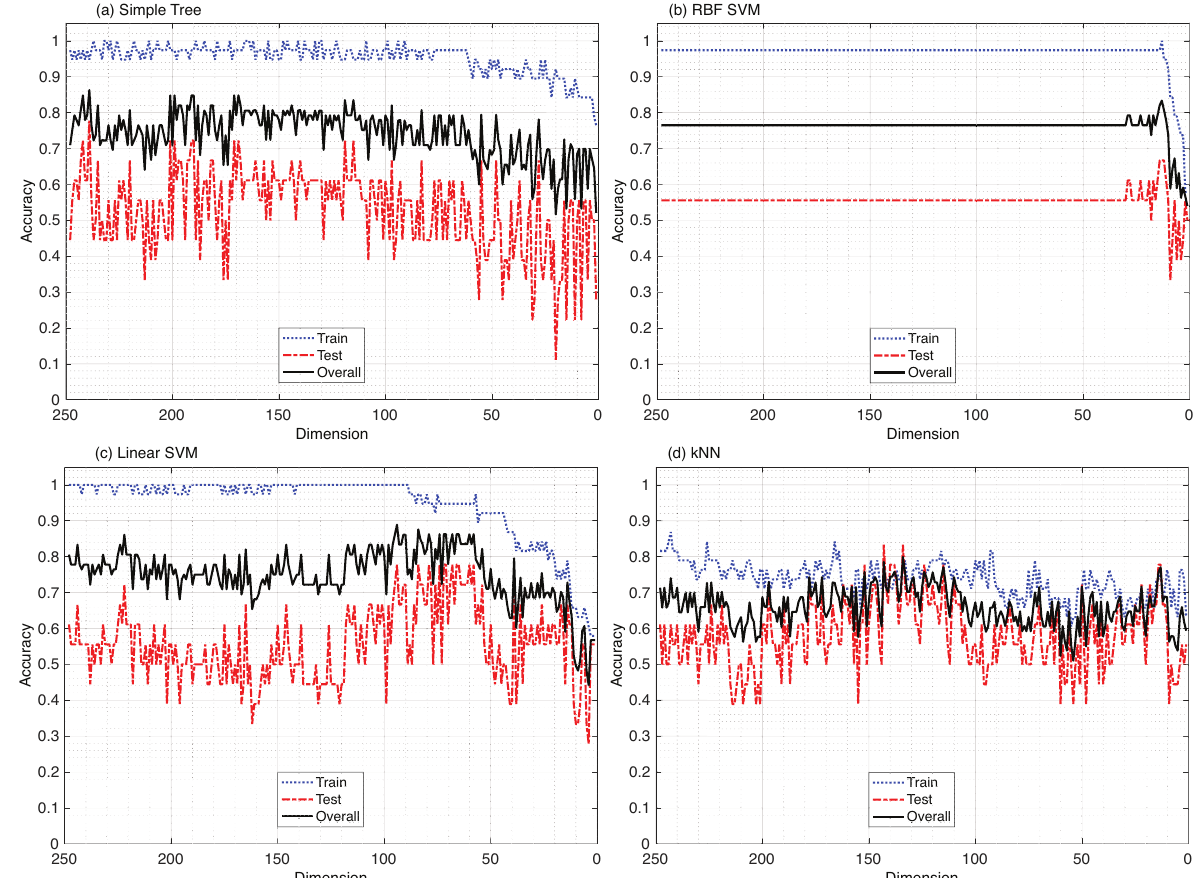
Figure 4. Filter method (benchmark): Four machine learning algorithms evaluated with respect to sequential dimensionality reduction using the mutual information relevance metric. ( a ) Simple Tree, ( b ) Radial Basis Function kernel Support Vector Machine, ( c ) Linear Support Vector Machine, ( d ) k -Nearest Neighbor. Data: N = Overall = 56 ( p = 32, n = 24 ) , R = Train = 38 ( p = 23, n = 15 ) , E = Test = 18 ( p = 9, n = 9 )